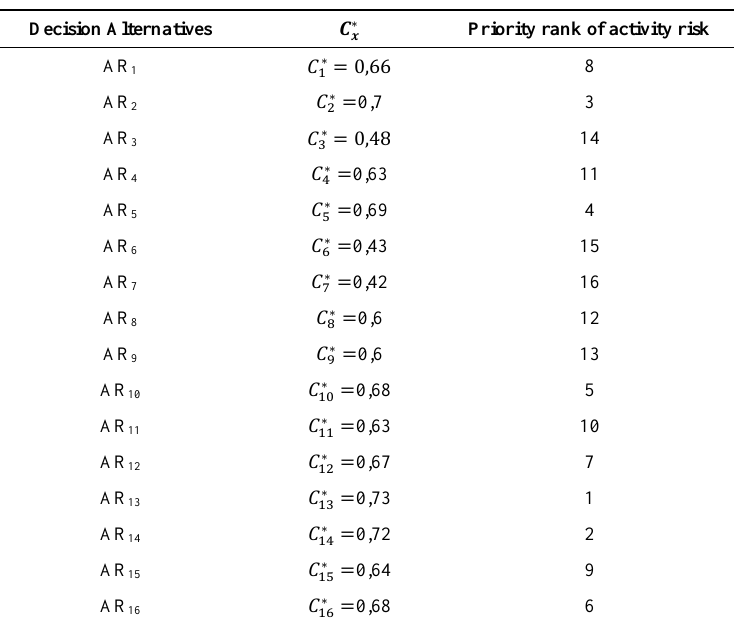
Table 12. Rank and 𝑪 𝒙∗ values of activity